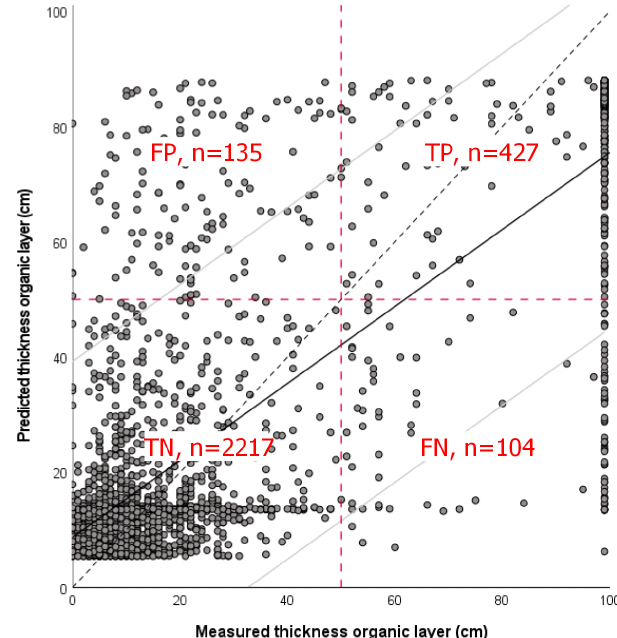
Figure 4. Predicted vs. measured continuous thickness of the or- ganic layer in the evaluation dataset ( n = 2883). Red lines indicate the quadrants of the confusion matrix for classified data using peat with ≥ 50cm depth. Dashed line indicates the 1 : 1 line and black line a linear regression ( R 2 = 0.67, p< 0 . 001), grey lines indicate 95% CI. Field measurements of peat thickness that were 99cm or above were reported as 99cm, hence the many overlapping data points.